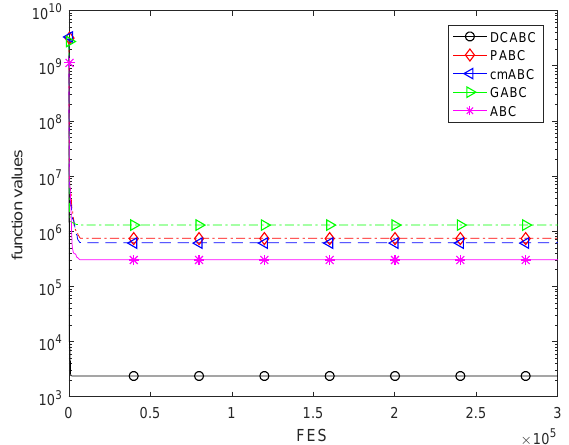
Figure 7. Convergence curves of five algorithms for f 10 with D = 30. (The optimal value of f 10 is 1000).